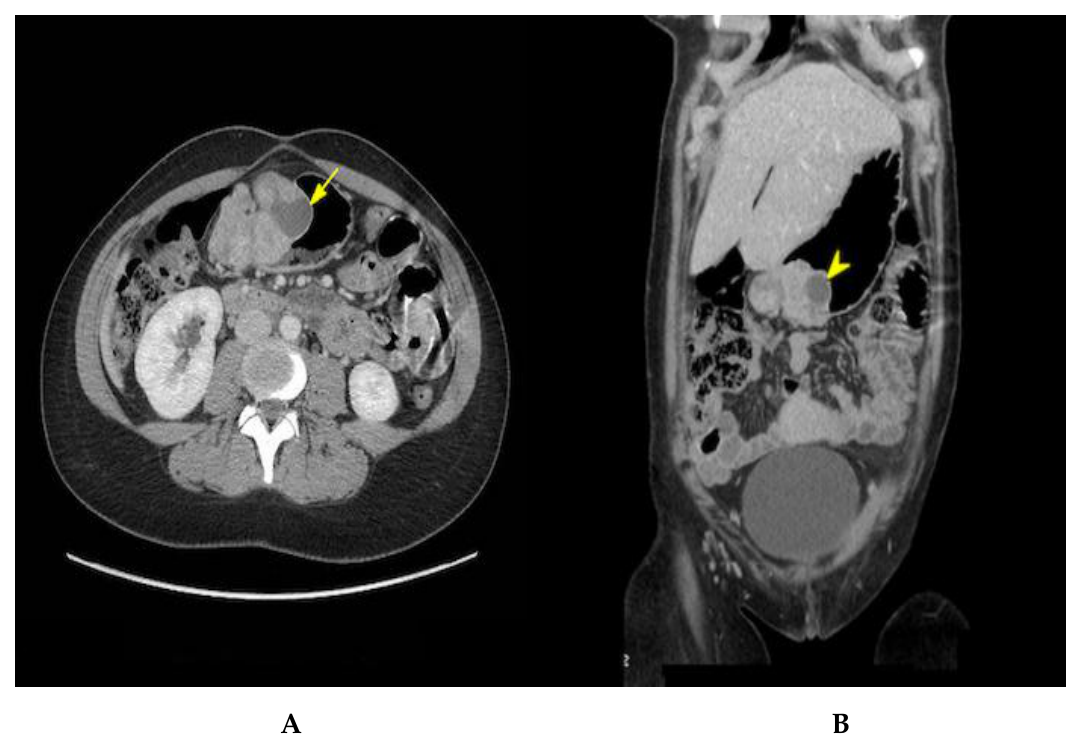
Figure 1. Axial ( A ) and coronal ( B ) contrast-enhanced CT view showing an 8.3 cm polylobate submucosal lesion with cystic components (yellow arrows) consistent with a GIST.